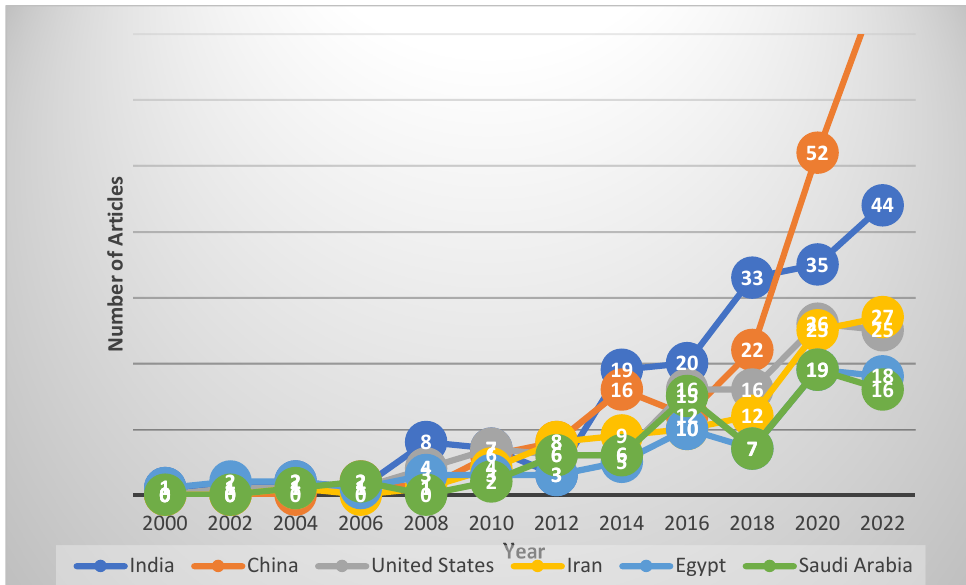
Figure 3. Comparison of the research growth trend in top producing countries. Table 5. The 15 most productive institutions and rank by number of publications. Institutes TA